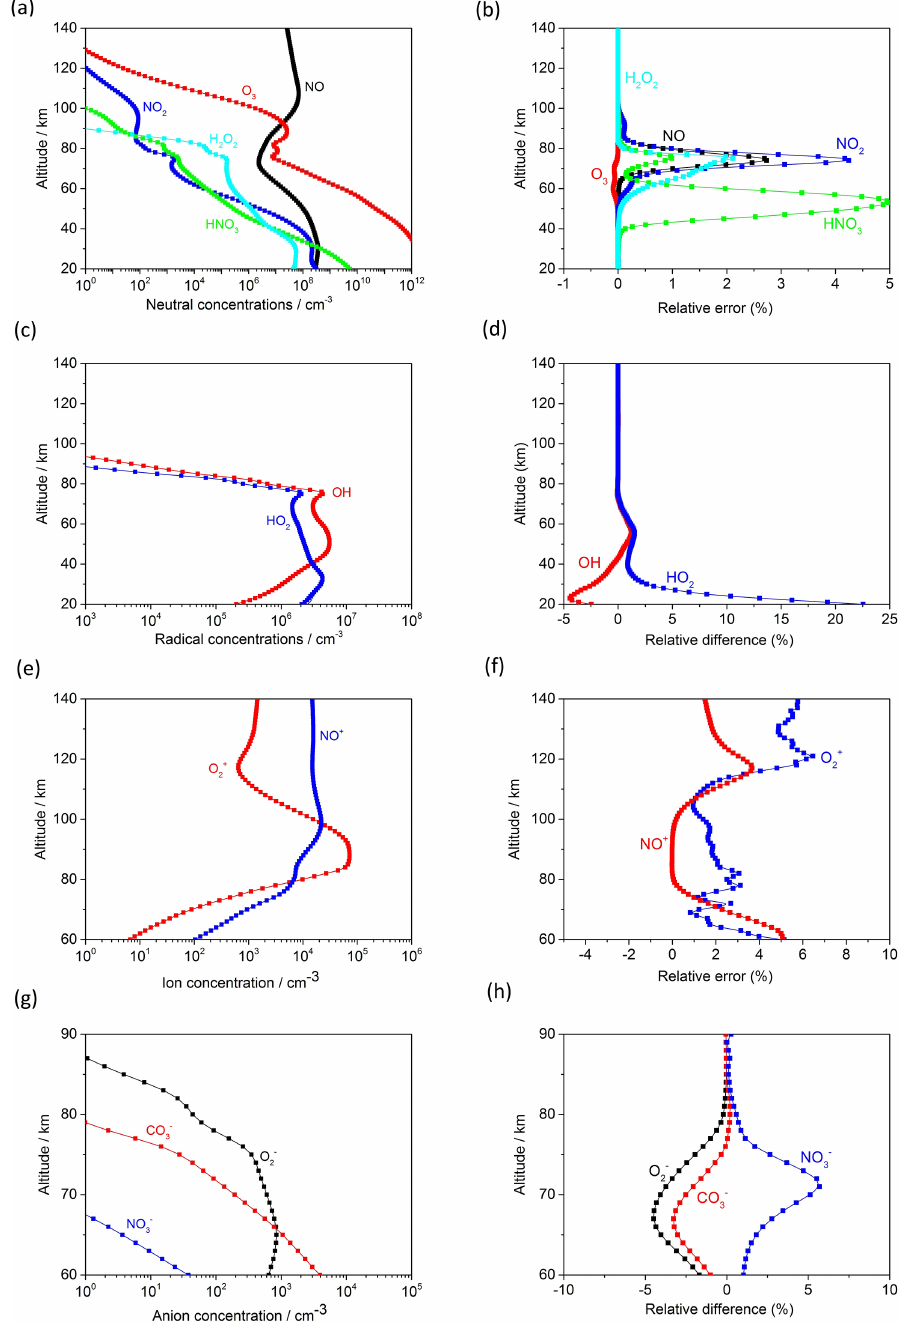
Figure 2. Atmospheric concentration profiles and relative differences calculated using the full SIC model and reduced (rSIC) model for 17 January 2005 at 17:50UT. In the left-hand panels the solid lines show the concentrations calculated by the full SIC model, while the symbols refer to the reduced rSIC model. The right-hand panels show the percentage difference between the rSIC and SIC models: (a) con- centrations and (b) percentage differences of HNO 3 , NO, NO 2 , O 3 and H 2 O 2 ; (c) concentrations and (d) percentage differences of OH and HO 2 ; (e) concentrations and (f) percentage differences of NO + and O + NO − and O − 3 2